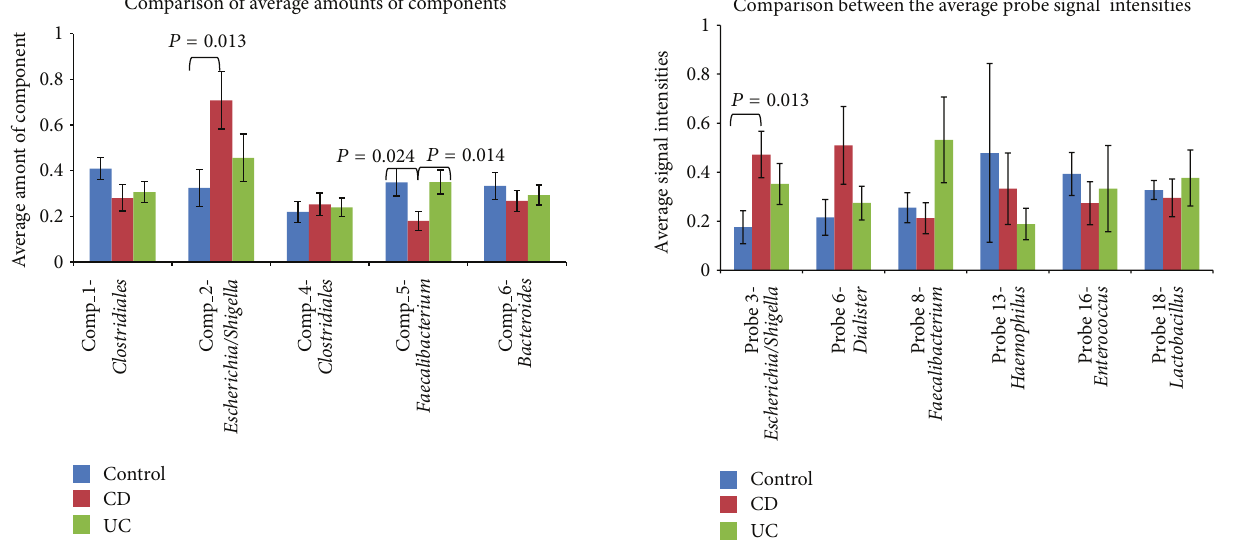
Figure 5: Comparison between the average amount of specific bacteria groups in the different disease states. The averages are calculated based on the height of the probe signals normalized by the signal height of the universal bacterial probe. Further, the averages are normalized to one because of Probe 18- Lactobacillus in particular, which gave much higher signals. There are 34 subjects in the control group, and the CD (Crohn’s Disease) and UC (Ulcerative colitis) group have 30 and 33 subjects, respectively. Standard error of arithmetic mean is shown. The significance of the differences between the averages were tested using a t -test where the statistical significance was accepted at 𝑃 < 0.05 . Only the statistically significant 𝑃 -value is shown in the